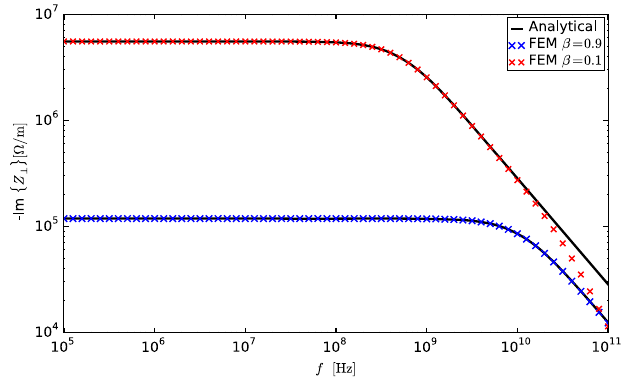
FIG. 5. Transverse space charge impedance (both direct and indirect). The dimensions are the same as in Fig. 4.